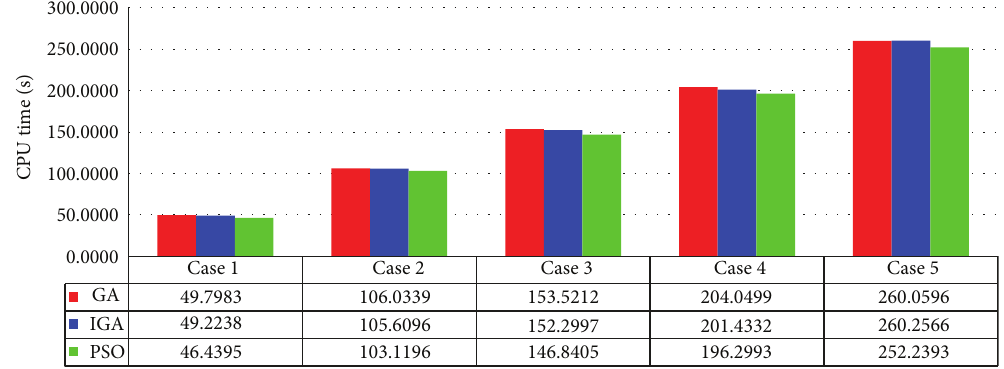
Figure 12: The CPU time (sec) under different cases and by three different algorithms.